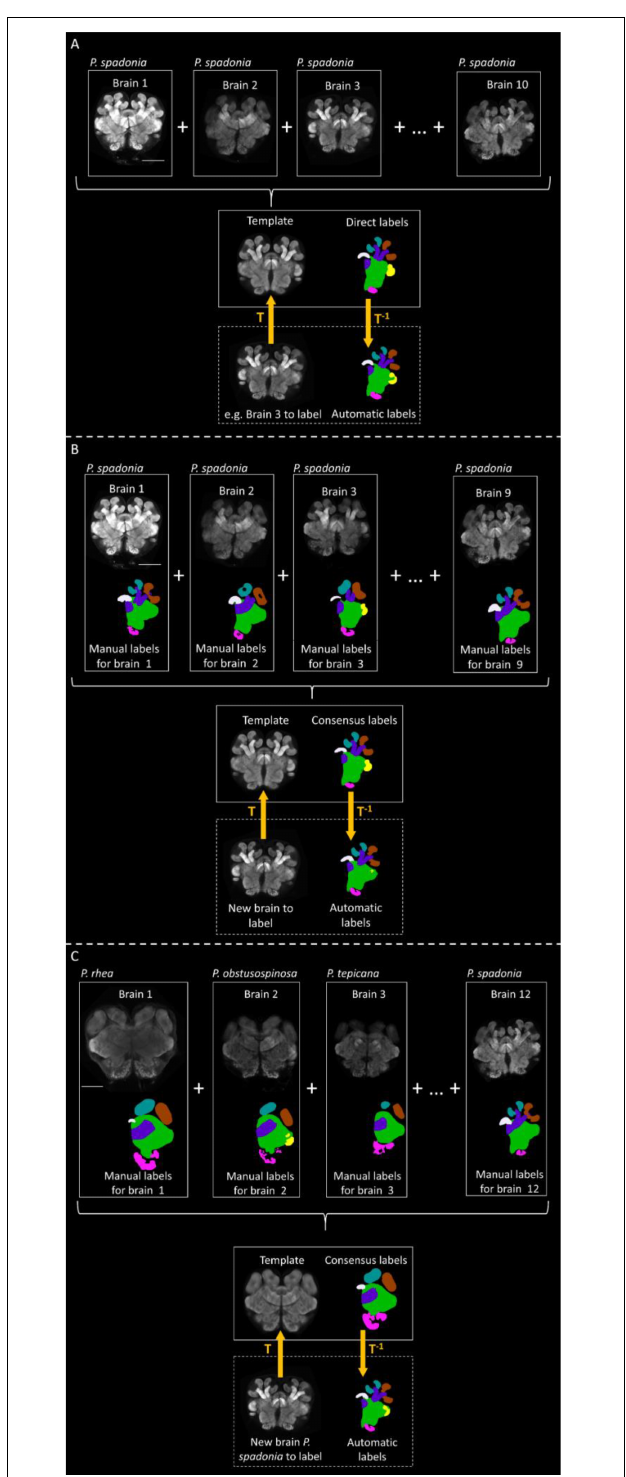
FIGURE 2 | Automatic labeling methods. (A) Ten confocal images of brains of P. spadonia minors are combined on a single group-wise template, which is manually traced (creating “direct labels”). Each brain used to build the template (and other new brains) can be registered against the template with a